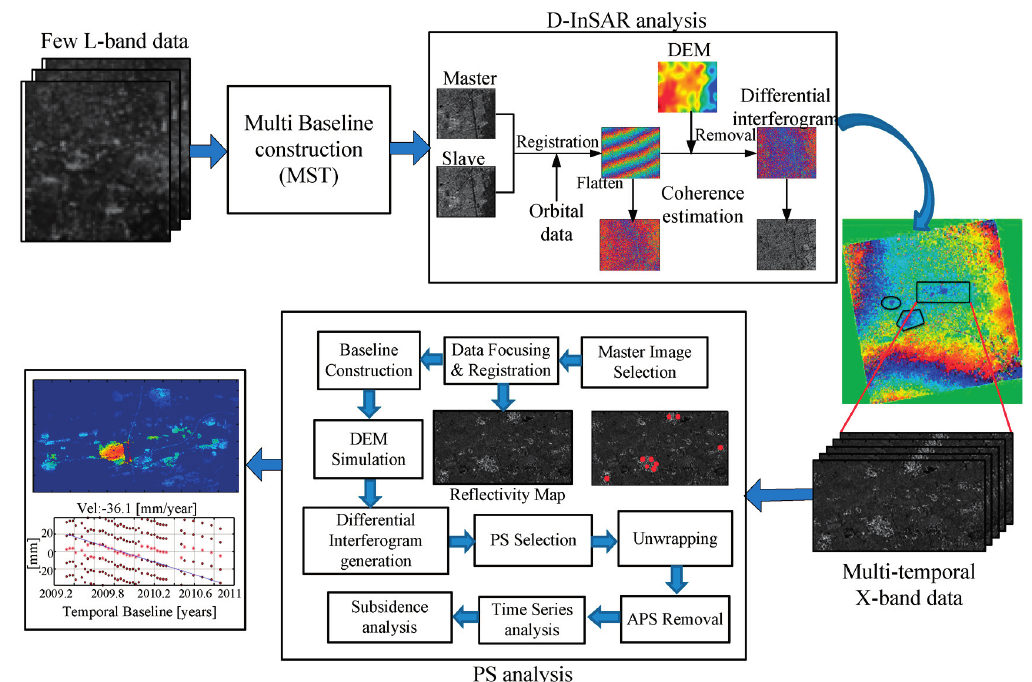
Figure 1. The framework of X-band optimized acquisition planning in combination with L-band, including multi-baseline construction based on MST, L-band D-InSAR analysis, potential deformation area detected and X-band PS